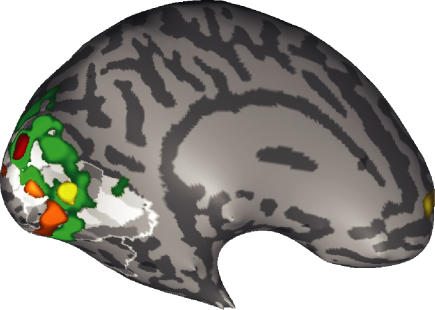
The brain regions highlighted above allow us to see a series of flashing images as smooth motion. This activity occurs in the primary visual cortex